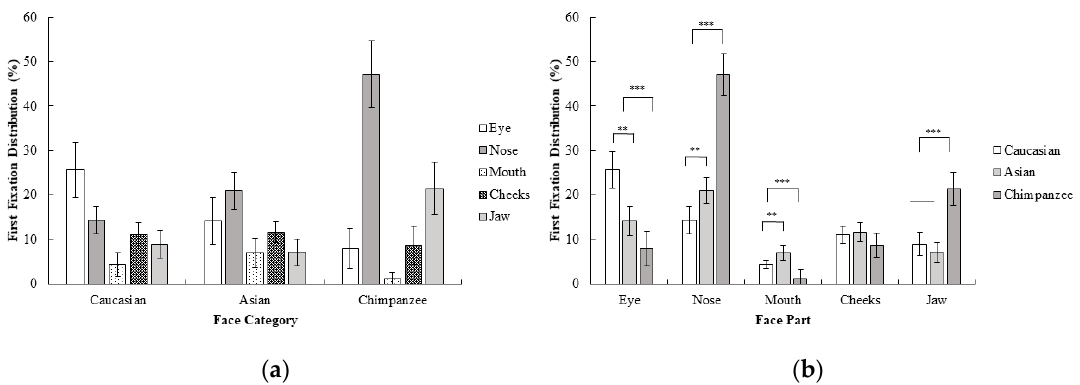
Figure 3. Mean percentage (with 95% CI) of first fixation frequency (%) as a function of ( a ) face category and ( b ) face part in Experiment 2.